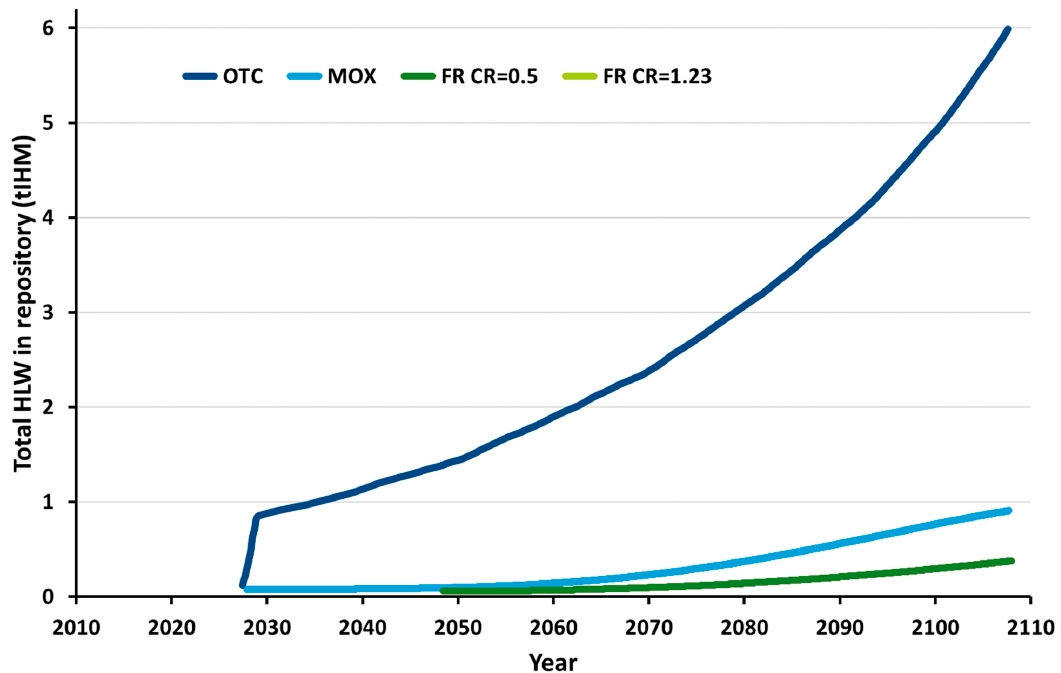
Figure 12. Reduction in the mass of HLW (where tIHM is tonnes of initial heavy metal) for disposal in the DGR, comparing the OTC, TTC and fast reactor fuel cycles. Redrawn from data in [54]. The lines for the 0.5 and 1.23 conversion ratios are coincident.